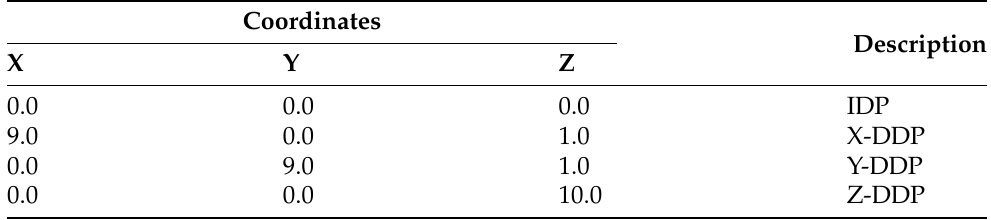
Table 6. Initial and desired